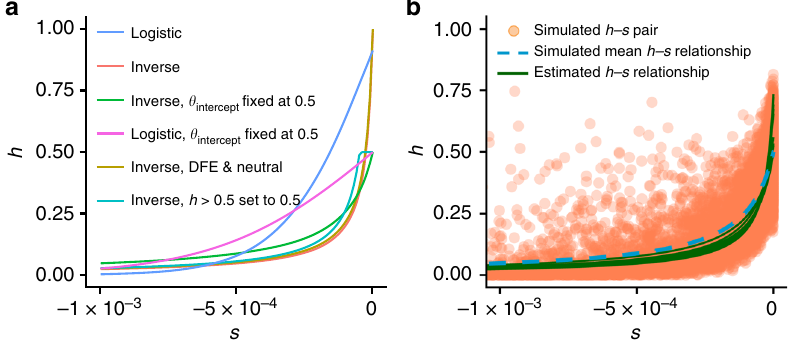
Fig. 3 Robustness of the inferred h – s relationship. a The inferred h – s relationship depends on the assumed functional form of the relationship and on assumptions regarding the DFE. However, all estimated curves converge to strong recessivity for selection coef fi cients s < − 0.0005 (see also Supplementary Table 3). The inverse h – s relationship is de fi ned by Eq. (1), the logistic relationship is de fi ned by the formula h ¼ θ b Substantial variation in the dominance coef fi cient h for particular values of s has only a modest effect on the estimation of the h – s relationship. The estimated curves (green; 10 replicates) closely follow the simulated mean relationship between h and s (dashed blue line). However, the estimated intercept parameter, de fi ning the dominance of almost-neutral mutations, is upwardly biased. Orange dots denoted individual h and s coef fi cients for